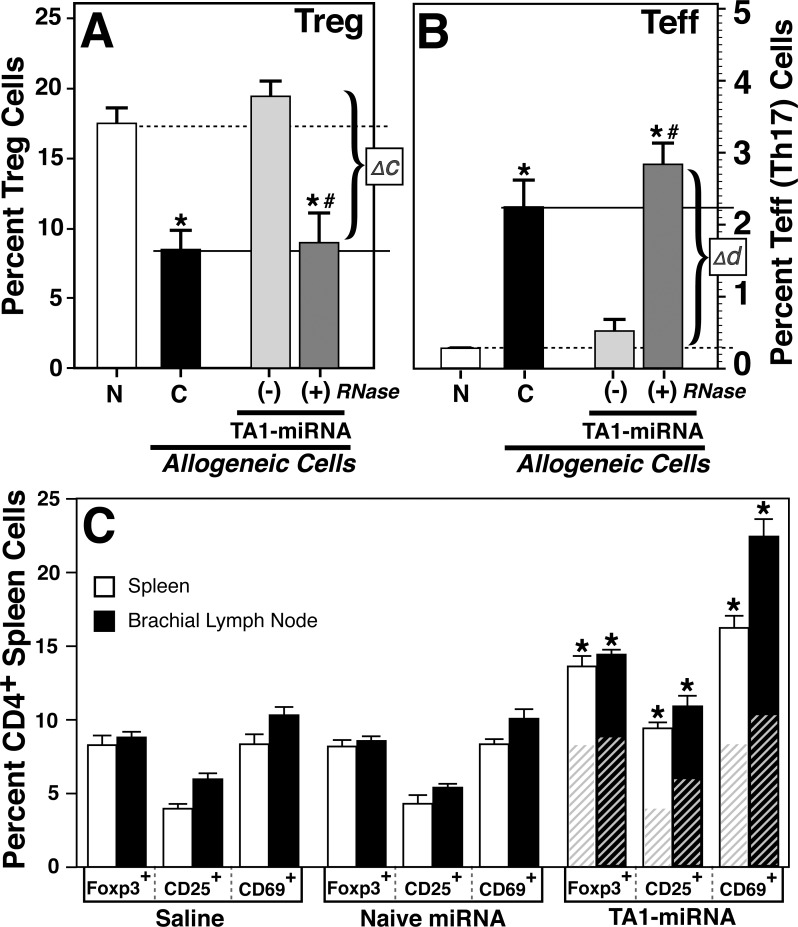
TA1 results in a decreased in vivo inflammatory response upon allogeneic cells challenge.In immunologically competent mice (Balb/c), TA1 completely abrogates the inflammatory response to allogeneic (C57Bl/6) splenocytes. Shown are the levels of Treg and Teff (Th17) cell levels in the spleen of naïve (N), allogeneic challenged (C) and TA1 treated (± RNase A treatment) mice 5 days post treatment. TA1 was administered 24 hours prior to administration of the allogeneic splenocytes. As noted, the ‘active’ agent of the TA1 preparation on Treg and Teff levels was fully degraded by RNase treatment (Δc/d, respectively). Dashed lines represents naïve resting levels of Treg or Th17 cells while the solid lines denote the mean Treg and Th17 cells of control mice 5 days post transfusion of unmodified, viable, allogeneic splenocytes. Data shown is the mean ± SD of a minimum of 8 mice per group. * Denotes significantly different (p<0.001) from naïve mice. # Denotes significantly different (p<0.001) from TA1 treated mice. Panel C:
In vivo effects of saline, naive miRNA or TA1-miRNA on Foxp3+, CD25+ and CD69+ T cells in the spleen and brachial lymph node. For ease of comparison, the cross-hatched regions of the TA1 group represent the mean saline values. Cell populations were determined 5 days post treatment with a minimum of 5 animals per treatment group. (*) Indicates significantly (p<0.001) different from saline group in Panels A-B. In Panel C (#) denotes significantly reduced from sample 1 but still significantly (p<0.01) elevated relative to saline group.